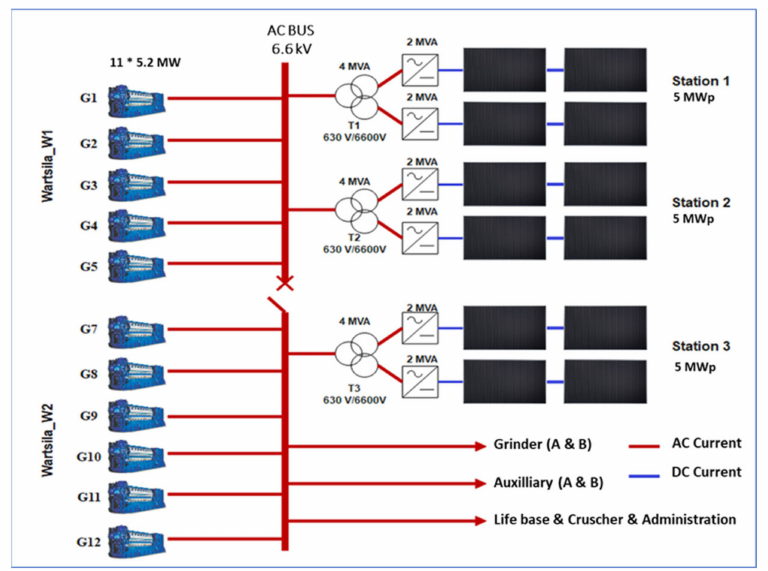
Figure 3. Structure of the Essakane PV/Diesel Hybrid Power Plant with engines and PV